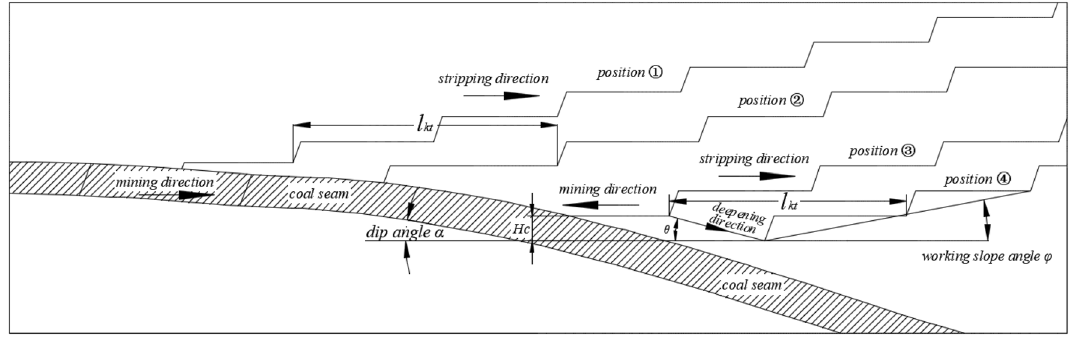
Fig. 1 Diagram of coal exposure in anticline